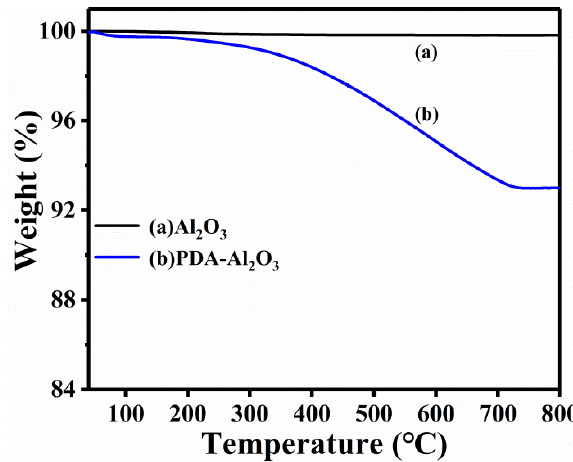
Figure 5. Thermogravimetric analysis (TGA) results for Al 2 O 3 and PDA-Al 2 O 3 .